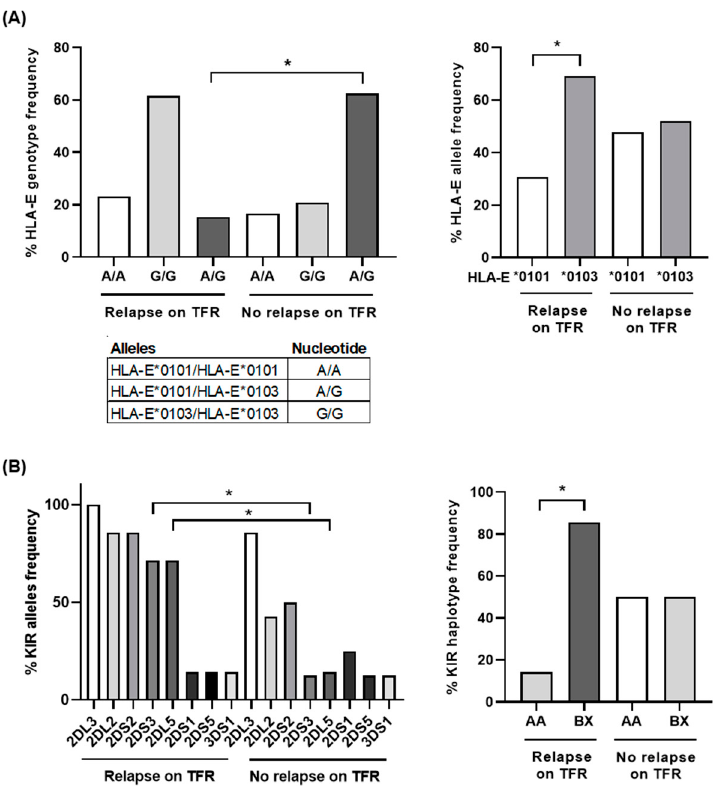
Figure 5. HLA-E and killer cell Ig-like receptor (KIR) genotyping in different groups of patients with CML. ( A ) Analysis by qPCR of the percentage of HLA-E genotyping and alleles frequency in patients with CML who relapsed during treatment interruption ( n = 13) in comparison with patients with CML who did not relapse ( n = 24). ( B ) Analysis of the percentage of KIR alleles and haplotypes frequency was performed in patients with CML who relapsed during treatment interruption ( n = 7) or not (Off TKI) ( n = 8). Each dot corresponds to one sample and lines represent mean ± SEM. Statistical significance was calculated using one-way ANOVA and Tukey’s multiple comparisons test. * p < 0.05.